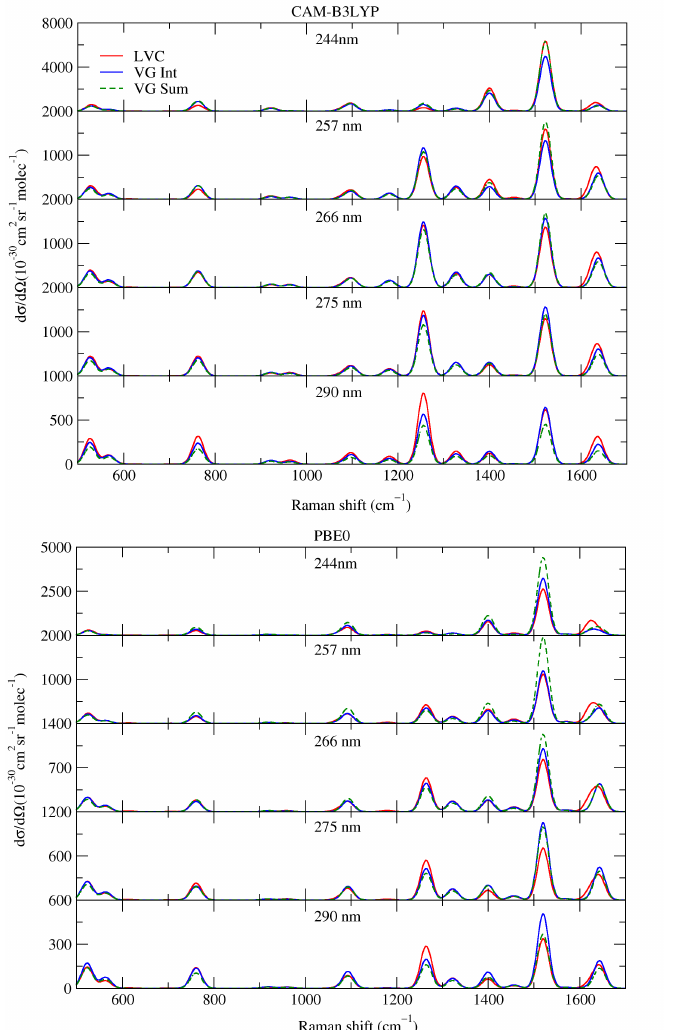
Figure 3. Vibrational Resonance Raman spectra of cytosine, computed by the LVC model (red lines), FC | VG Int (blue lines), and FC | VG Sum (dashed green lines) levels, convoluted with a Lorentzian with damping, γ = 0.04 eV, and a Gaussian of HWHM = 0.12 eV, calculated by CAM-B3LYP and PBE0 with 6-311G+(d,p) basis sets in